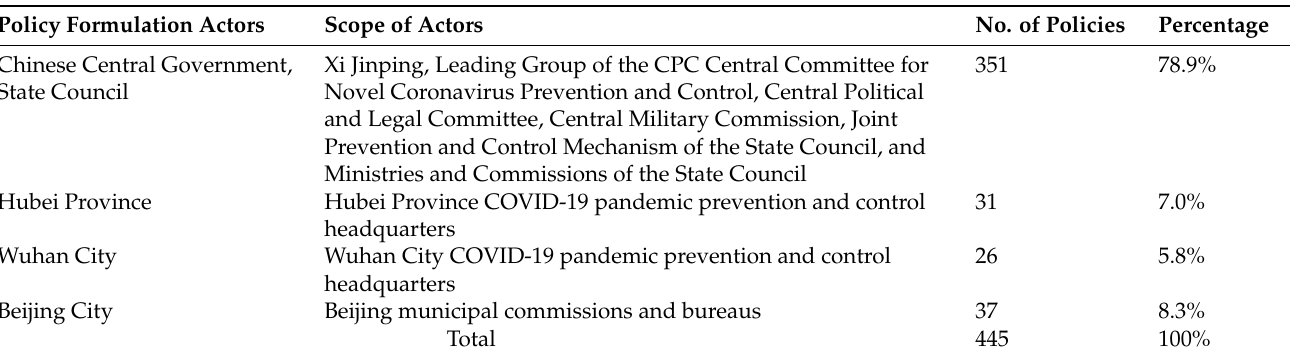
Table 1. Selected data on the COVID-19 pandemic prevention and control policies from three levels of government in